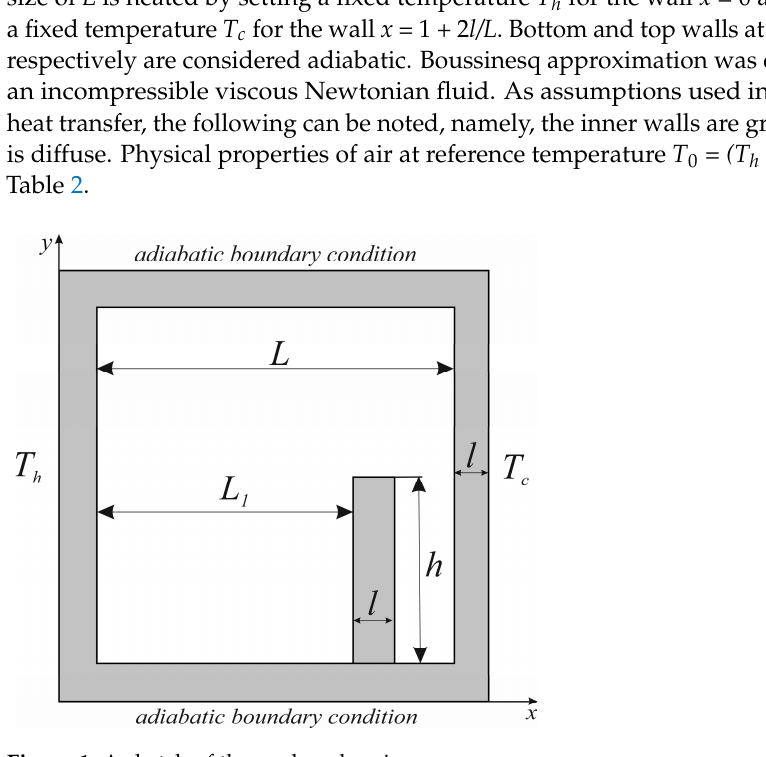
Figure 1. A sketch of the analyzed region.